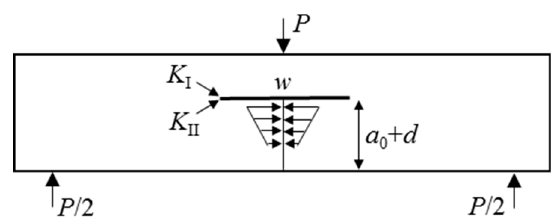
Figure 13. External forces applied on the test beam with a preset crack.